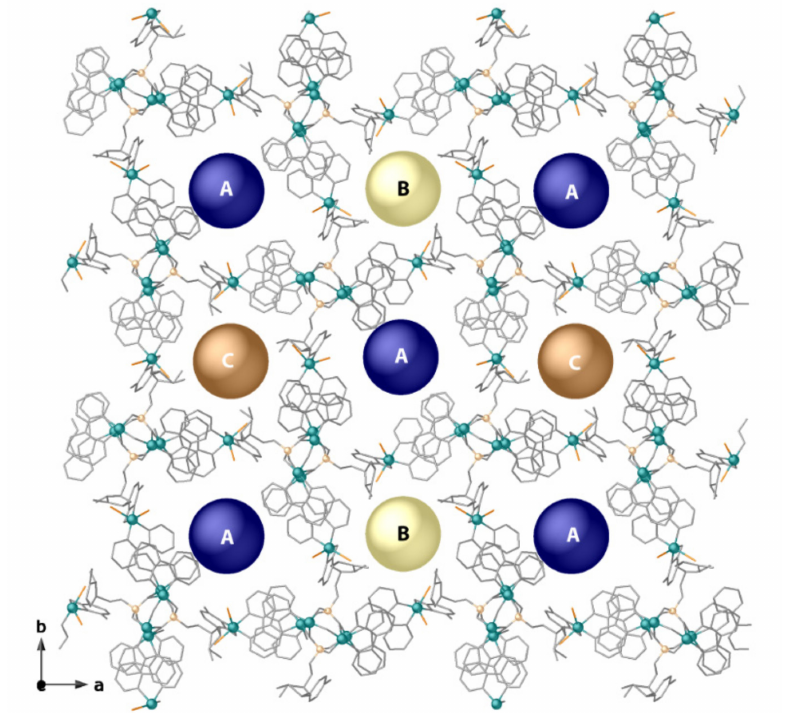
Figure 3. View along c crystallographic axis of the hydrophobic ( A ) and hydrophilic chiral nanopores ( B , C ), highlighted by dummy atoms (blue, gold, and brown for different types of pores). Color scheme: copper, cyan spheres; phosphorous, orange spheres; oxygen, nitrogen, carbon, grey sticks; bromide, brown sticks. Hydrogen atoms and lattice water molecules have been omitted for the sake of